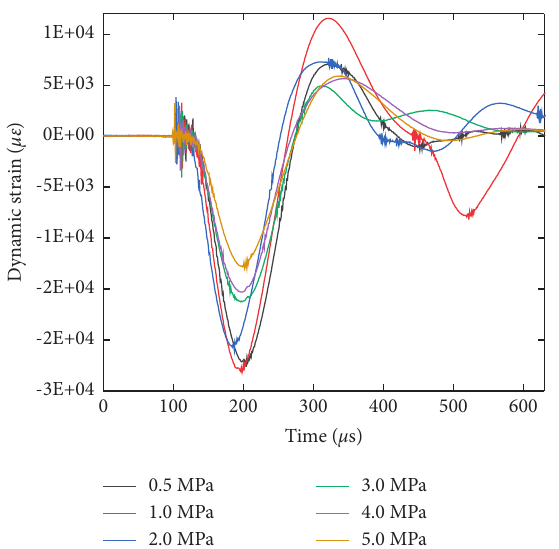
Figure 5: The dynamic strain curve of T 8 in Model 1 versus time.